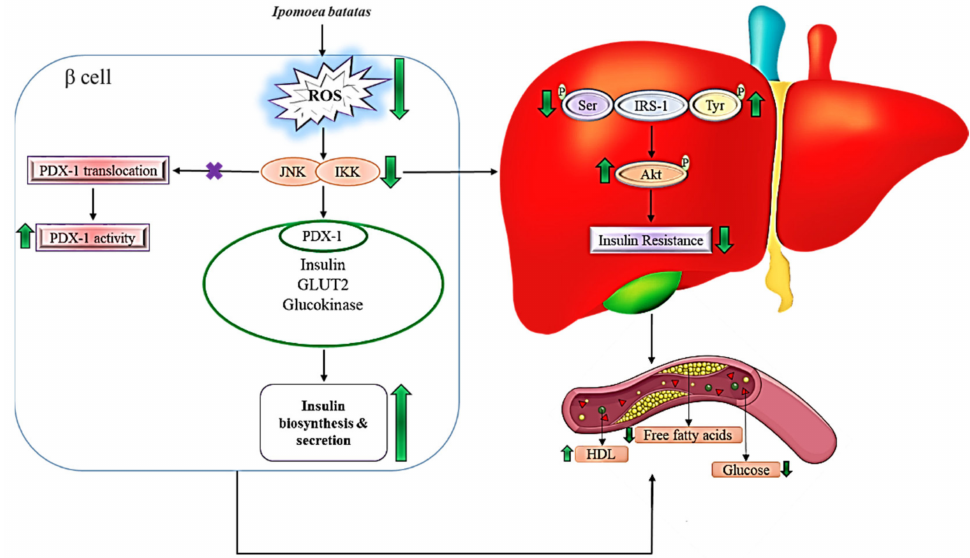
Figure 3. Mechanism of action of Ipomoea batatas in reducing hyperglycemia and regulating dyslipi- demic